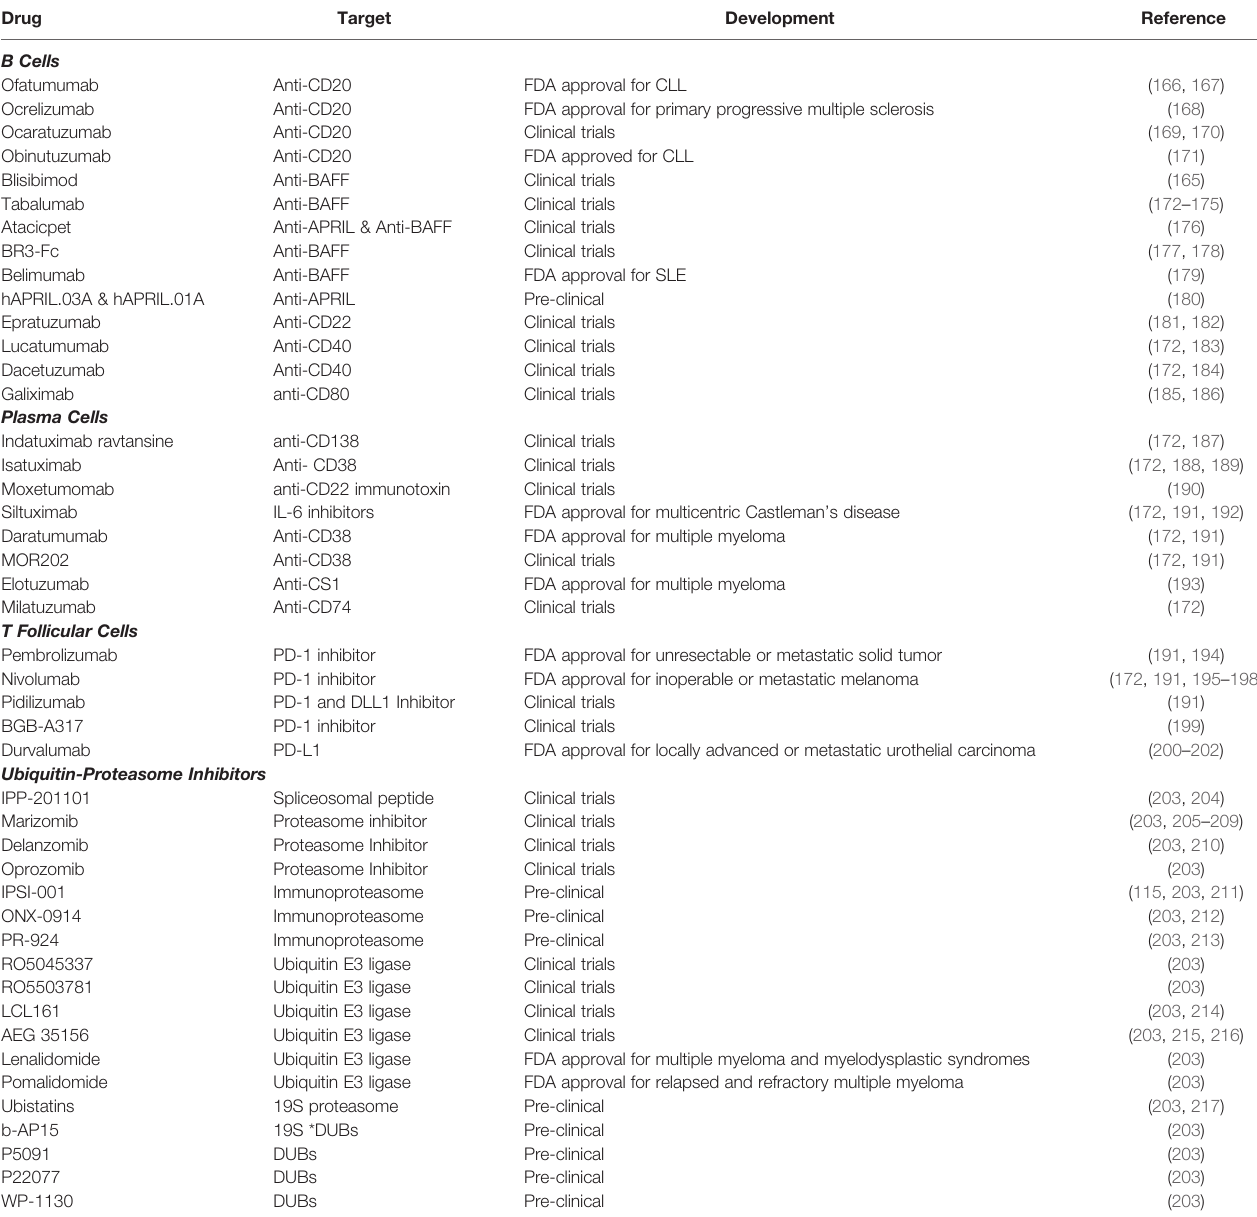
TABLE 1 | Broad Overview of Possible Therapeutics for New Desensitization Regimens.